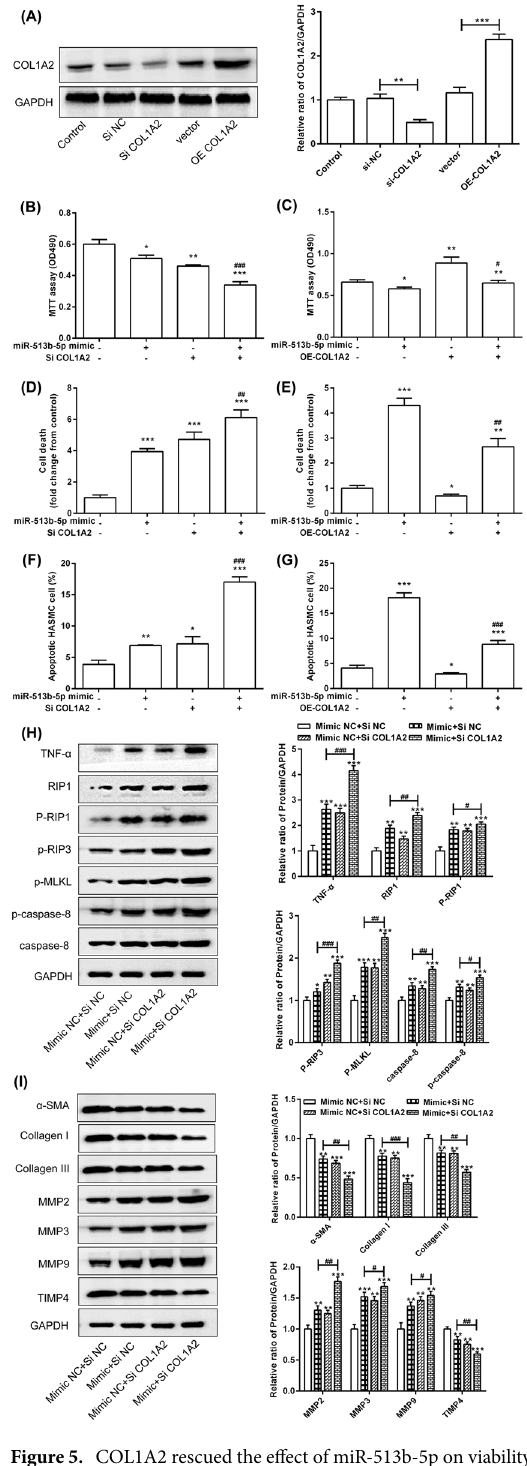
Figure 5. COL1A2 rescued the effect of miR-513b-5p on viability of HASMC by the RIP1-RIP3-MLKL and MMP pathways. ( A ) The protein and mRNA expression was detected after COL1A2 interference and over-expression. ( B ) Interference with COL1A2 enhanced the inhibitory effect of miR-513b-5p on the cell proliferation. ( C ) Over-expression of COL1A2 inhibited the inhibitory effect of miR-513b-5p on cell proliferation. ( D ) Interference with COL1A2 enhanced the induction of cell death by miR-513b-5p. ( E ) Over-expression of COL1A2 inhibited the induction of cell death by miR-513b-5p. ( F ) Interference with COL1A2 enhanced the induction of cell apoptosis by miR-513b-5p. ( G ) Over-expression of COL1A2 inhibited the induction of cell apoptosis by miR-513b-5p. COL1A2 regulated the expression of related proteins in the ( H ) RIP1-RIP3-MLKL pathway and ( I ) MMP pathway. All data were expressed as the mean ± standard deviation, and three independent experiments were carried out. Compared with mimic NC + siRNA NC group, * p < 0.05, ** p < 0.01, and *** p < 0.001. Compared with miR-513b-5p mimic + siRNA NC group, # p < 0.05, ## p < 0.01, and ### p < 0.001. One-way ANOVA with two-sided LSD post hoc test was